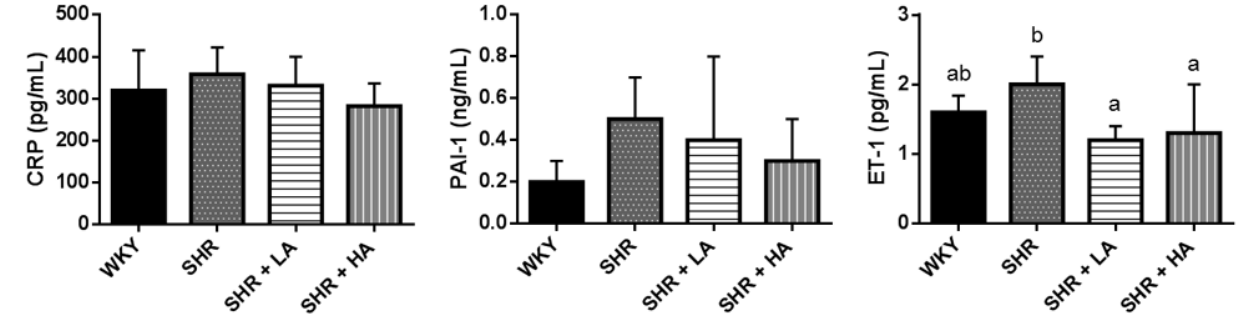
Figure 4. Plasma CRP, PAI-1, and ET-1 levels of rats in different groups. Values are presented as the mean ± SD ( n = 10). ab Different superscript letters indicate a significant difference ( p < 0.05). CRP, C-reactive protein; PAI-1, plasminogen activator inhibitor-1; ET-1, endothelin-1. WKYWistar Kyoto rats fed an AIN-93M diet; SHR, spontaneously hypertensive rats fed an AIN-93M diet; SHR + LA, SHRs fed an AIN-93M diet containing 12% dehulled adlay powder; SHR + HA, SHRs fed an AIN-93M diet containing 24% dehulled adlay powder.